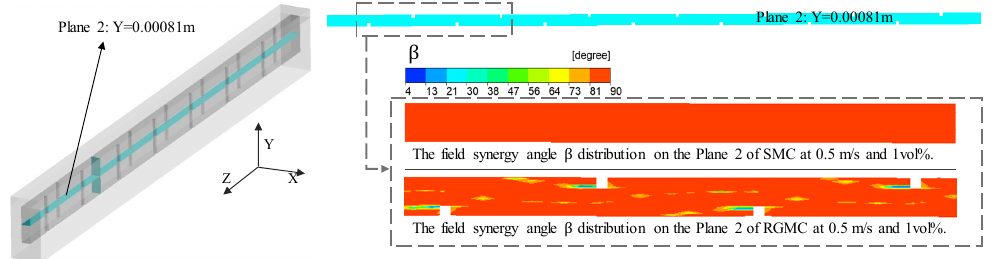
Figure 8. The streamline and velocity distribution of two microchannels with volume fraction 1%. ( a ) Two planes in the microchannel fluid domain. ( b ) The streamline on the Plane 2 of two microchannels. ( c ) The velocity distribution on the Plane 2 of two microchannels. Figure 9 shows the distribution of β values on Plane 2 of SMC and RGMC. For SMC, the β values are around 85, while for the RGMC, the β values near the groove region are significantly reduced to around 40, even to below 10. This indicates better convective heat transfer performance. As seen in Figure 8b,c, this decrease in synergy angle of heat transfer β and enhancement in heat transfer is due to the disturbance near the groove. Moreover, the region near the center line also shows a lower β around 40–50, indicating the influence of the groove on the main flow except in the boundary layer region.